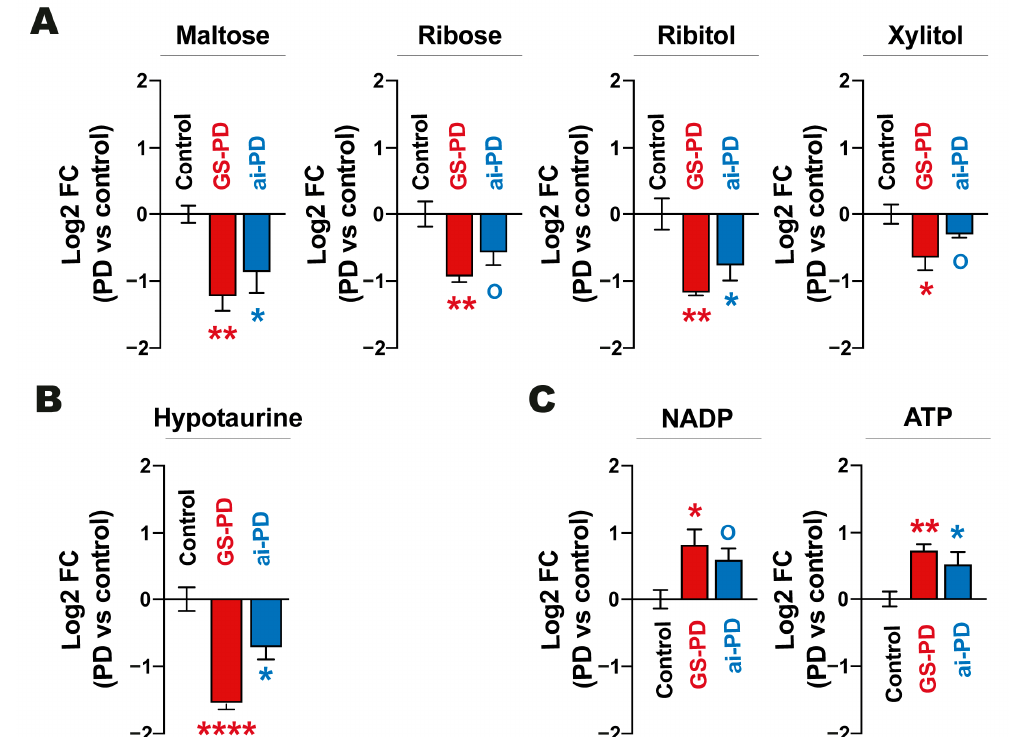
Figure 3. Histograms showing the average ( ± standard error of the mean (SEM)) of log2-fold change (Log2 FC) concentrations of different metabolites significantly decreased ( A , B ) or increased ( C ) in the liver of genetic (carrying the p.G2019S mutation in LRRK2 ; GS-PD) and acute intoxication PD (ai-PD) mouse models ( n = 4–5). For statistical analyses, p -values were calculated by one-way ANOVA (analyzing the metabolites individually) and differences were evaluated as statistically significant when p -values were: ◦ ( p < 0.1), * ( p < 0.05) and ** ( p <